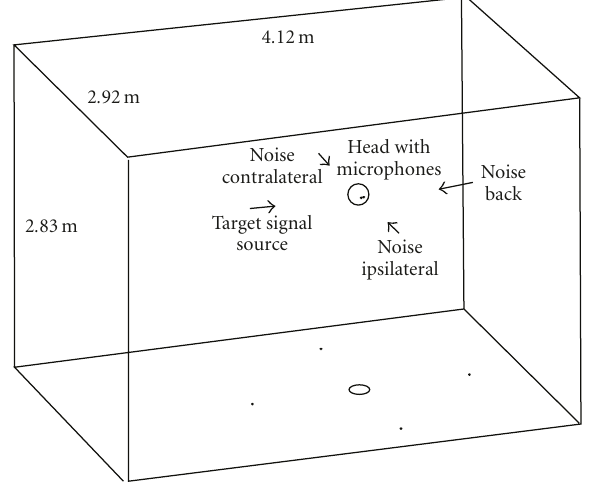
Figure 3: Schematic drawing of the simulated room including the head of the listener, modeled as a rigid sphere, and 4 sound sources at a distance of 1m from the center of the head of the listener.